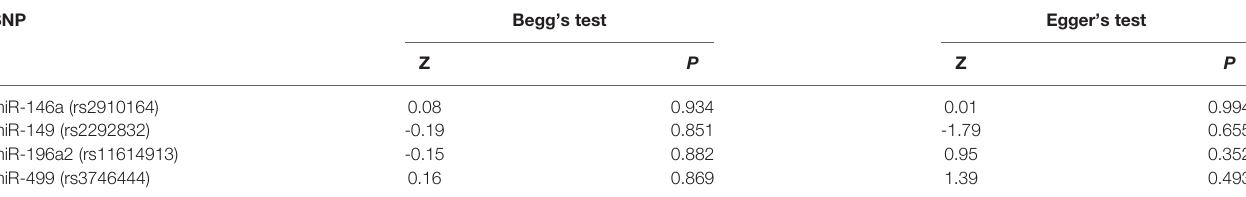
TABLE 3 | Summary of Begg ’ s and Egger ’ s tests. SNP